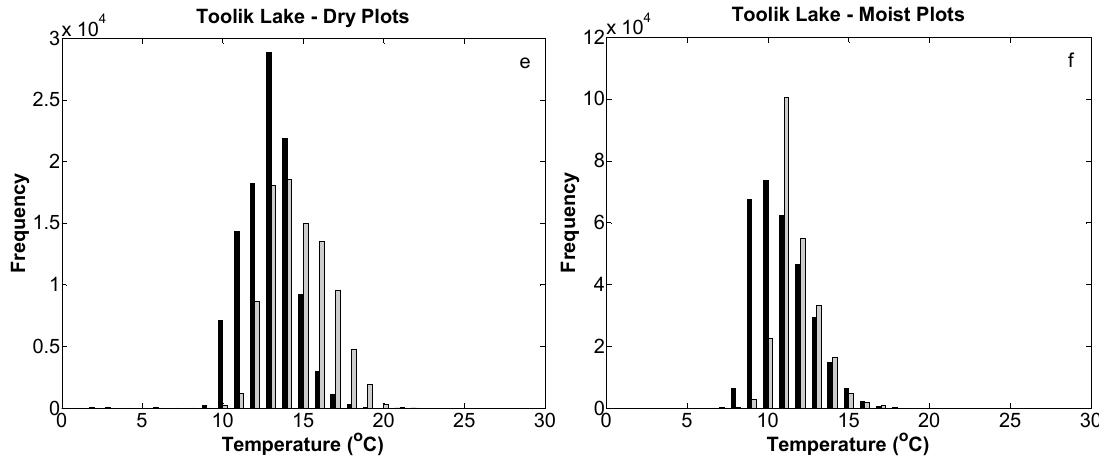
Figure 11. Histograms of pixel temperatures within the OTCs ( gray ) and the coinciding control plots ( black ) at each of the three locations. Pixel values for all four plots and each treatment (OTC or control) at Barrow dry ( a ); Barrow wet ( b ); Atqasuk dry ( c ); Atqasuk wet ( d ); Toolik Lake dry ( e ); and Toolik Lake moist ( f ) are presented.